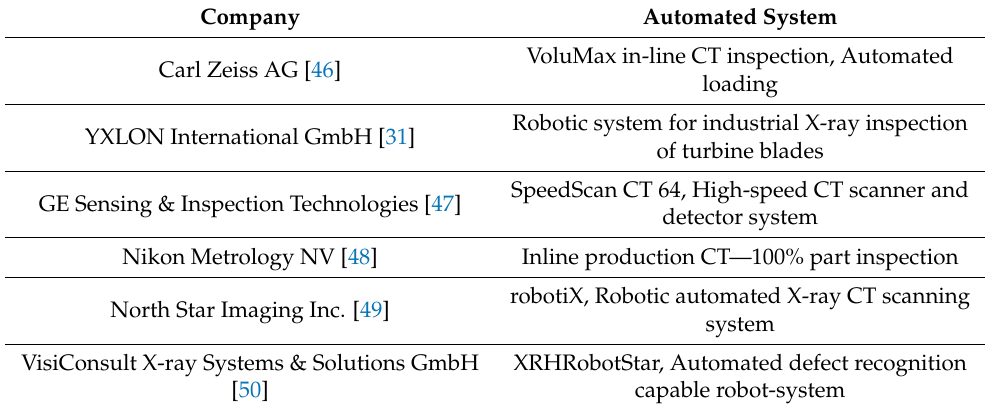
Table 1. Examples of commercially available industrial X-ray CT systems with robotic